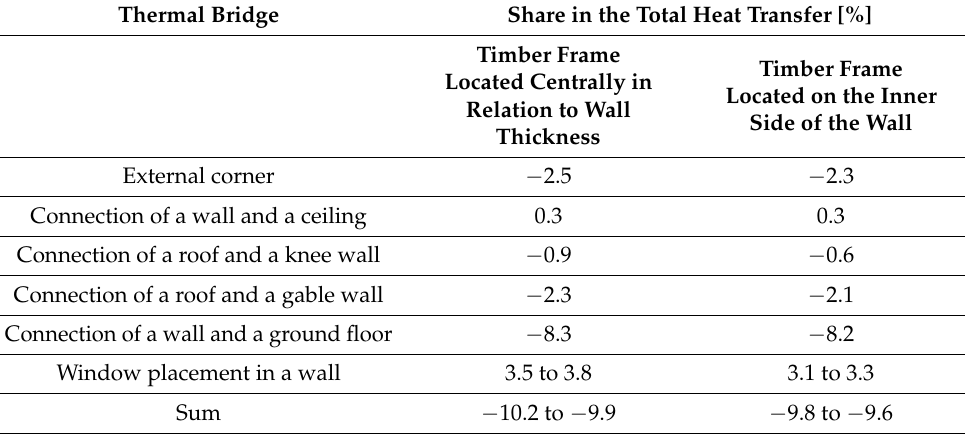
Table 6. Share of the thermal bridges in the total heat transfer. Thermal Bridge Share in the Total Heat Transfer [%] Timber Frame Timber Frame Located Centrally in Located on the Inner Relation to Wall Side of the Wall Thickness External corner − 2.5 − 2.3 Connection of a wall and a ceiling 0.3 0.3 Connection of a roof and a knee wall − 0.9 − 0.6 Connection of a roof and a gable wall − 2.3 − 2.1 Connection of a wall and a ground floor − 8.3 − 8.2 Window placement in a wall 3.5 to